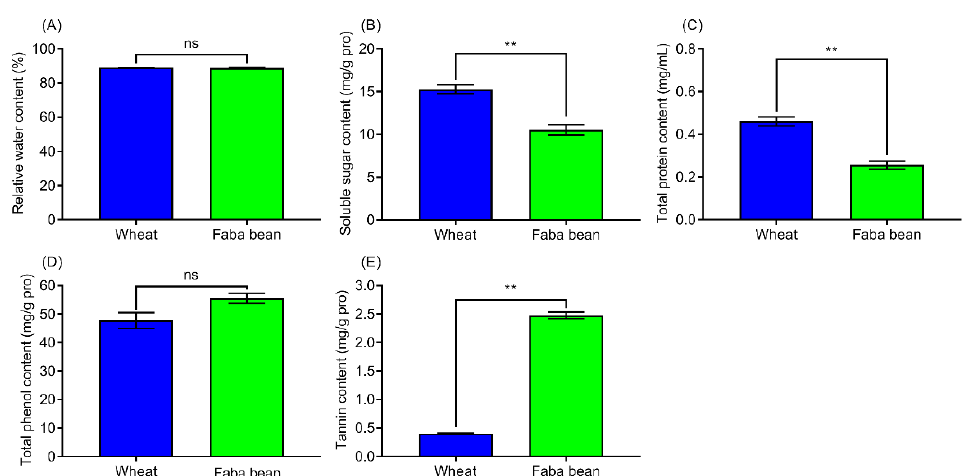
Figure 3. The relative water ( A ), soluble sugar ( B ), total protein ( C ), total phenol ( D ), and tannin contents ( E ) in wheat and faba bean leaves. All data are presented as the mean ± standard error (SE). The value bars with “ns” are not significant; “ ** ” on the top of standard error bars indicate a significant difference between two host species (independent sample t -tests, p < 0.01).